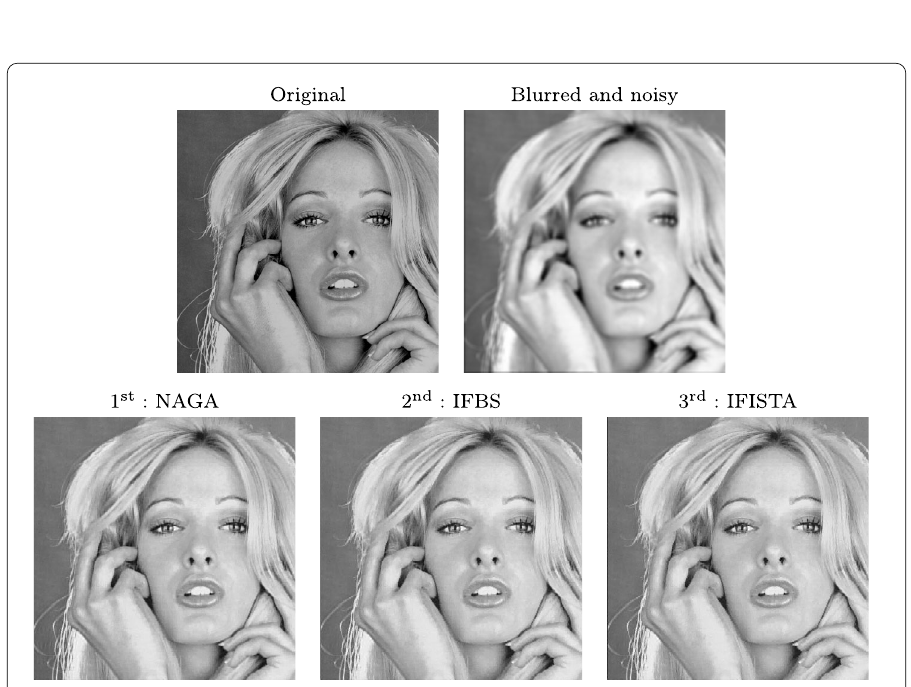
Figure 10 Top three fast convergence with good performance for deblurring of Woman